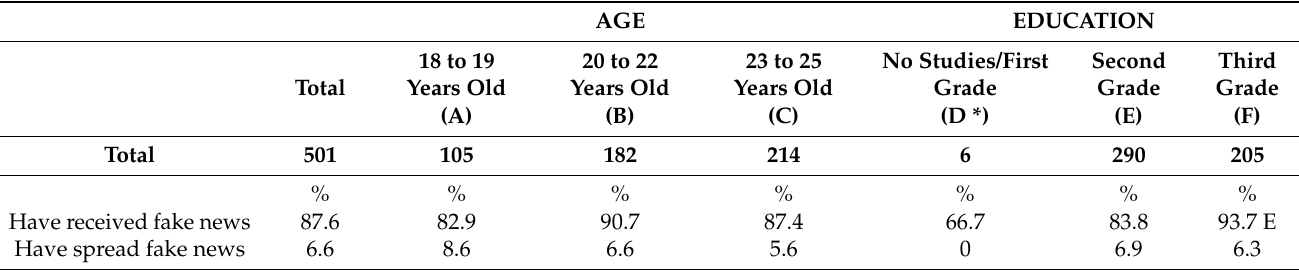
Table 14. Question 9: Now think specifically about what you do when you receive or forward fake news. Have you ever received, through any medium, fake news? Q.10: Have you ever spread a fake news item through any medium knowing that it was fake?